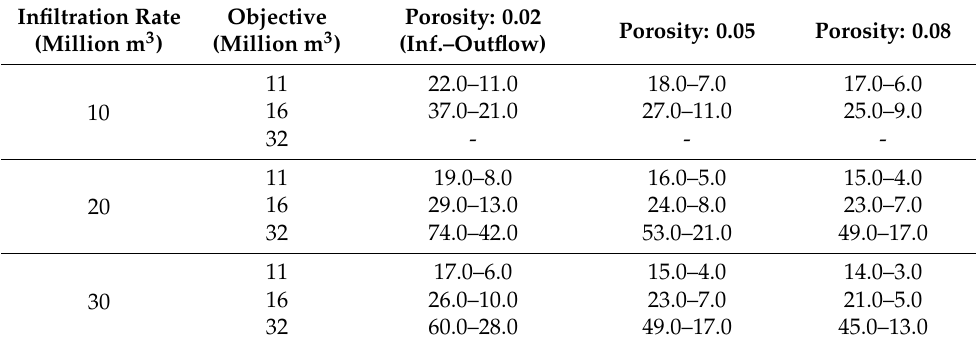
Table 4. Total amount of infiltrated water (Inf.) and of outflow at the coasts in Mm 3 .